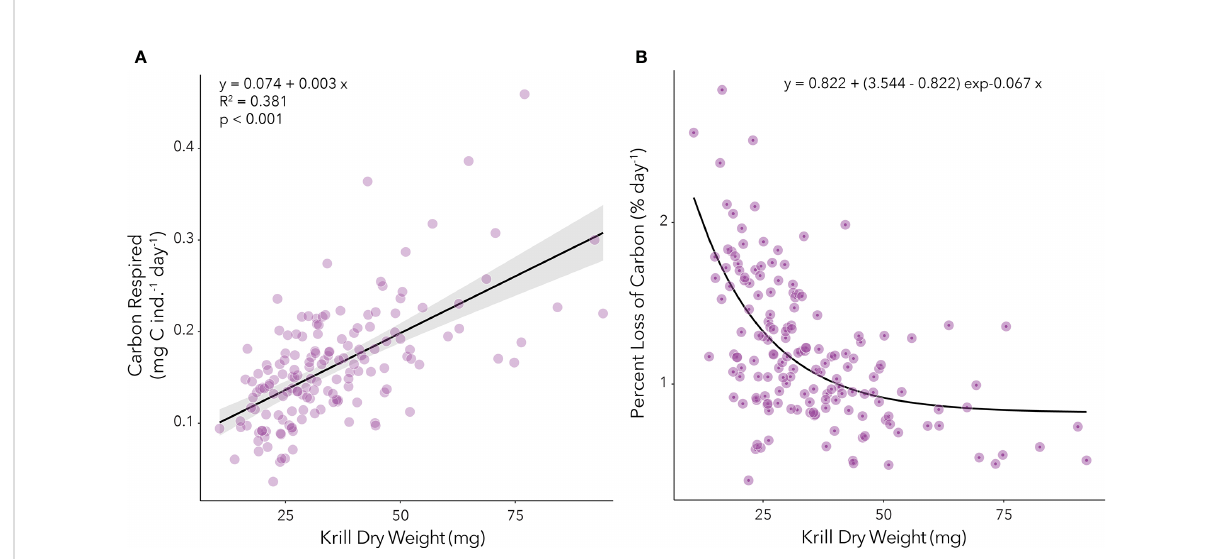
FIGURE 3 (A) Relationship between carbon respired (mg C ind. -1 day -1 ) and dry weight (mg) of juvenile krill during the fall and winter. The linear regression equation is provided, as are the adjusted r-squared and p-values. (B) Relationship between percent body carbon loss per day (% day -1 ) and dry weight (mg) of juvenile krill during the fall and winter. The non-linear regression equation is